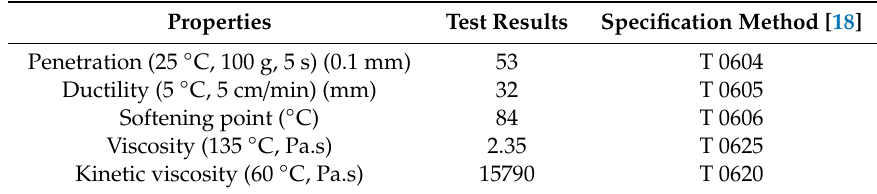
Table 1. Properties of styrene–butadiene–styrene (SBS) modified binder.